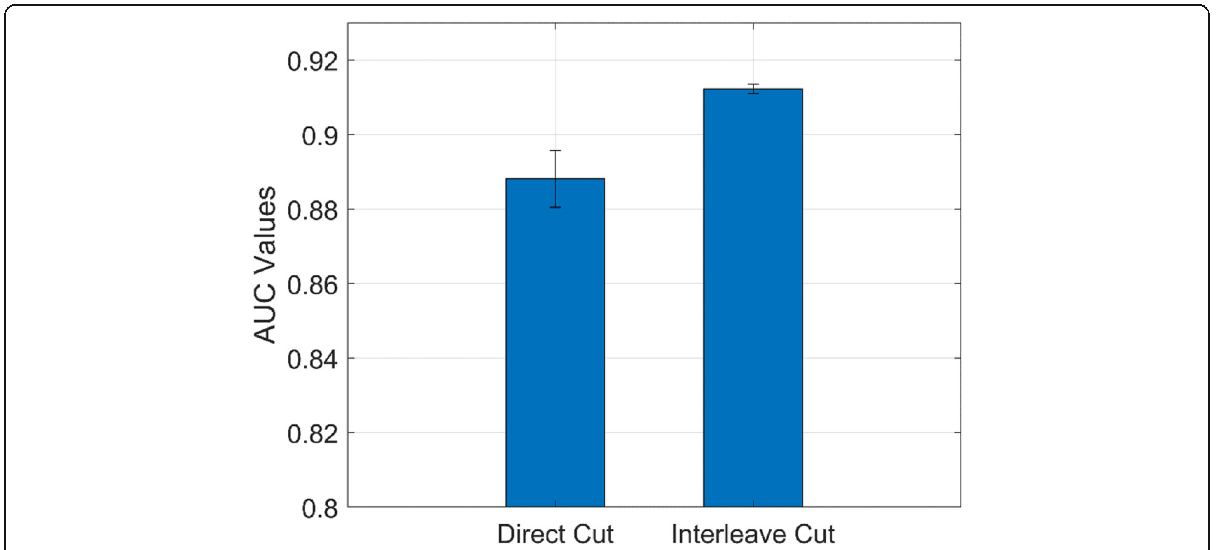
Fig. 6 Area under the curve values of direct-cut and